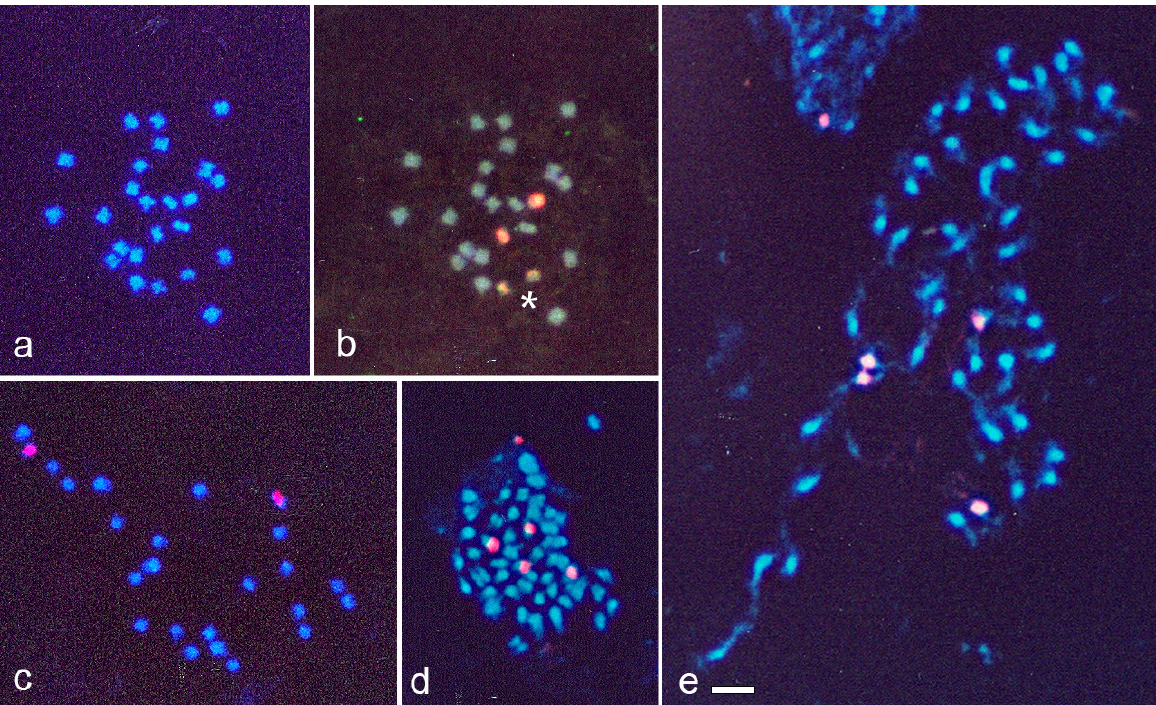
Figure 1. Chromosomes of Adenia fruticosa (a-b, 2n = 24) , A. spinosa (c, 2n = 24) , and A. glauca (d-e, 2n = 48) . Note the similarity in chromosome size and morphology (a,b), the occurrence of four 35S rDNA sites (red) in b, d and e, and only two sites in c . Prophase chromosomes of A. glauca (e) show the chromosome condensation pattern. Bar in and corresponds to 5